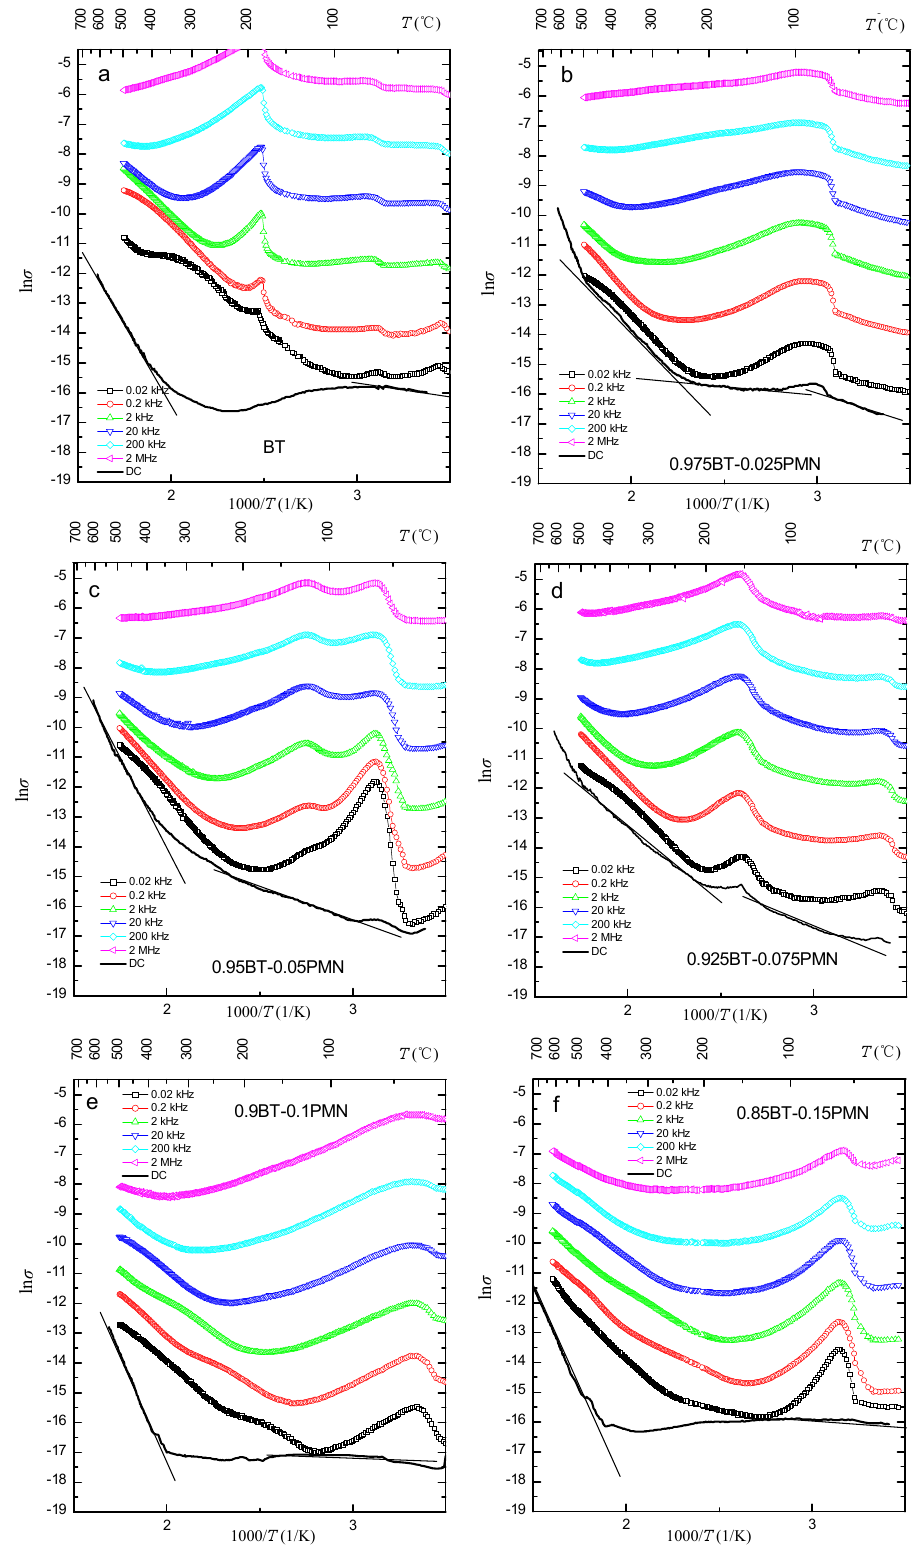
Fig. 6 Variation of electric conductivity with 1000/ T for various frequencies for (1  x )BT– x PMN ceramics: (a) x = 0, (b) x = 0.025, (c) x = 0.05, (d) x = 0.075, (e) x = 0.1, and (f) x =